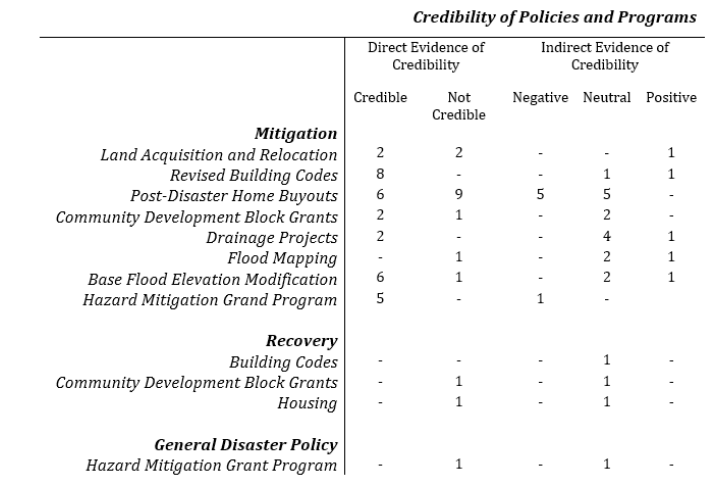
Table 3: Perceived Credibility of Individual Policies and